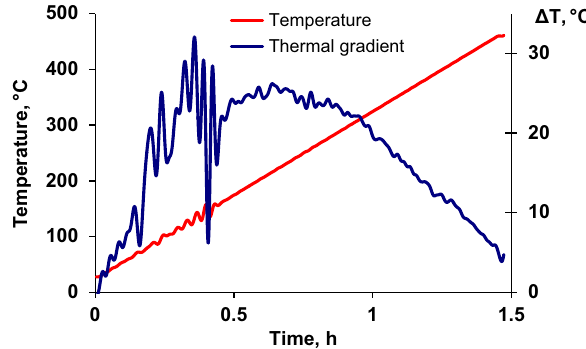
Fig. 2 Temperature ( red ); and temperature non-uniformity ( blue : thermal gradient)—measured as the temperature differential, D T between the sample and control thermocouple—within HPMD filled with high-pressure CO